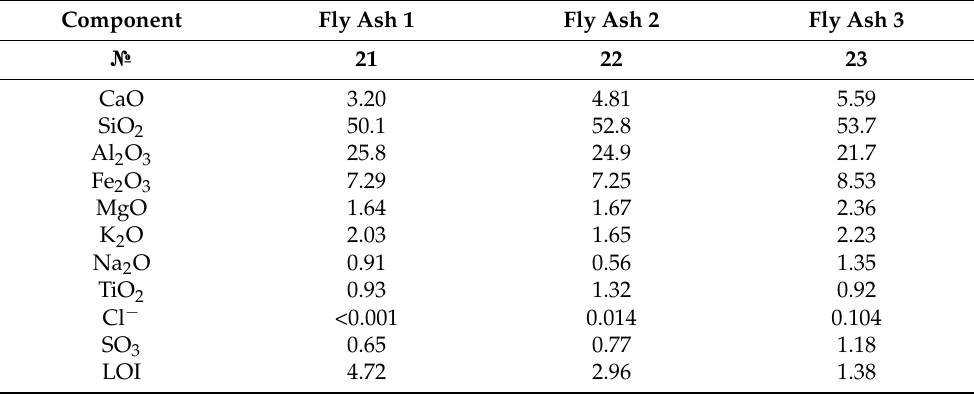
Table 3. Chemical composition of the fly ashes (in